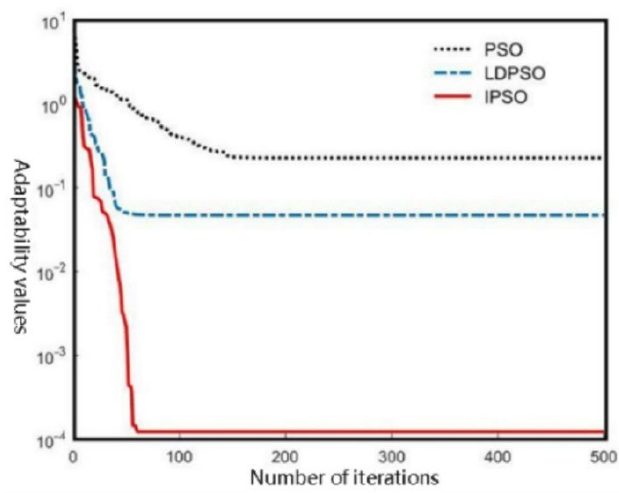
Figure 2. Convergence of Schwefel 1.2 function.